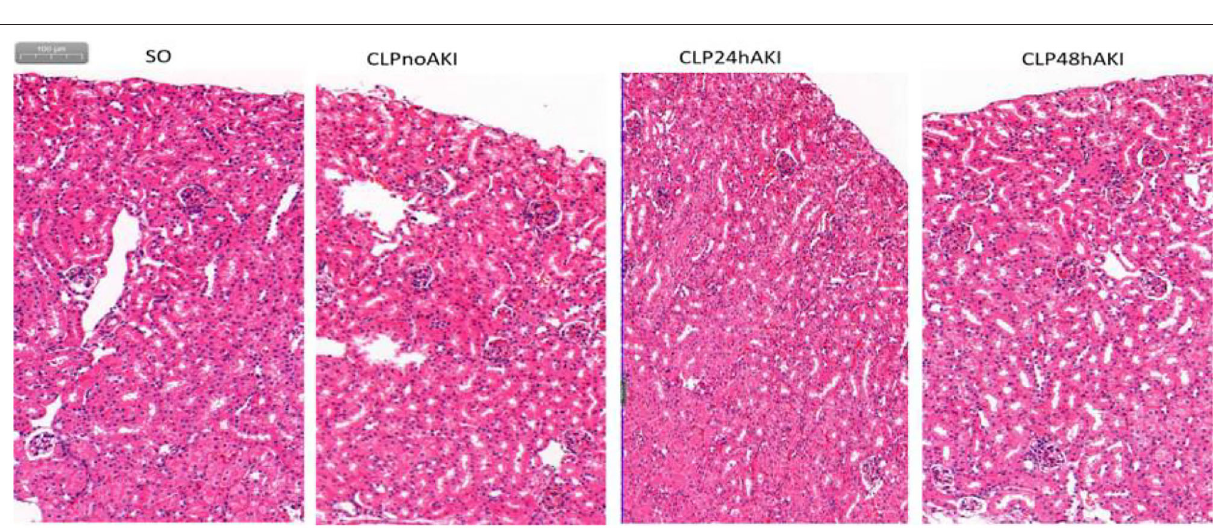
FIGURE 2 | Representative HE staining images (original magnification, × 100) of the cortex and the outer stripe of the outer medulla (OSOM) in each group were shown. There was no significant difference in tubular change scores between each group. SO, Sham Operation; CLPnoAKI, CLP without AKI; CLP24hAKI, AKI after CLP 24h; CLP48hAKI, AKI after CLP